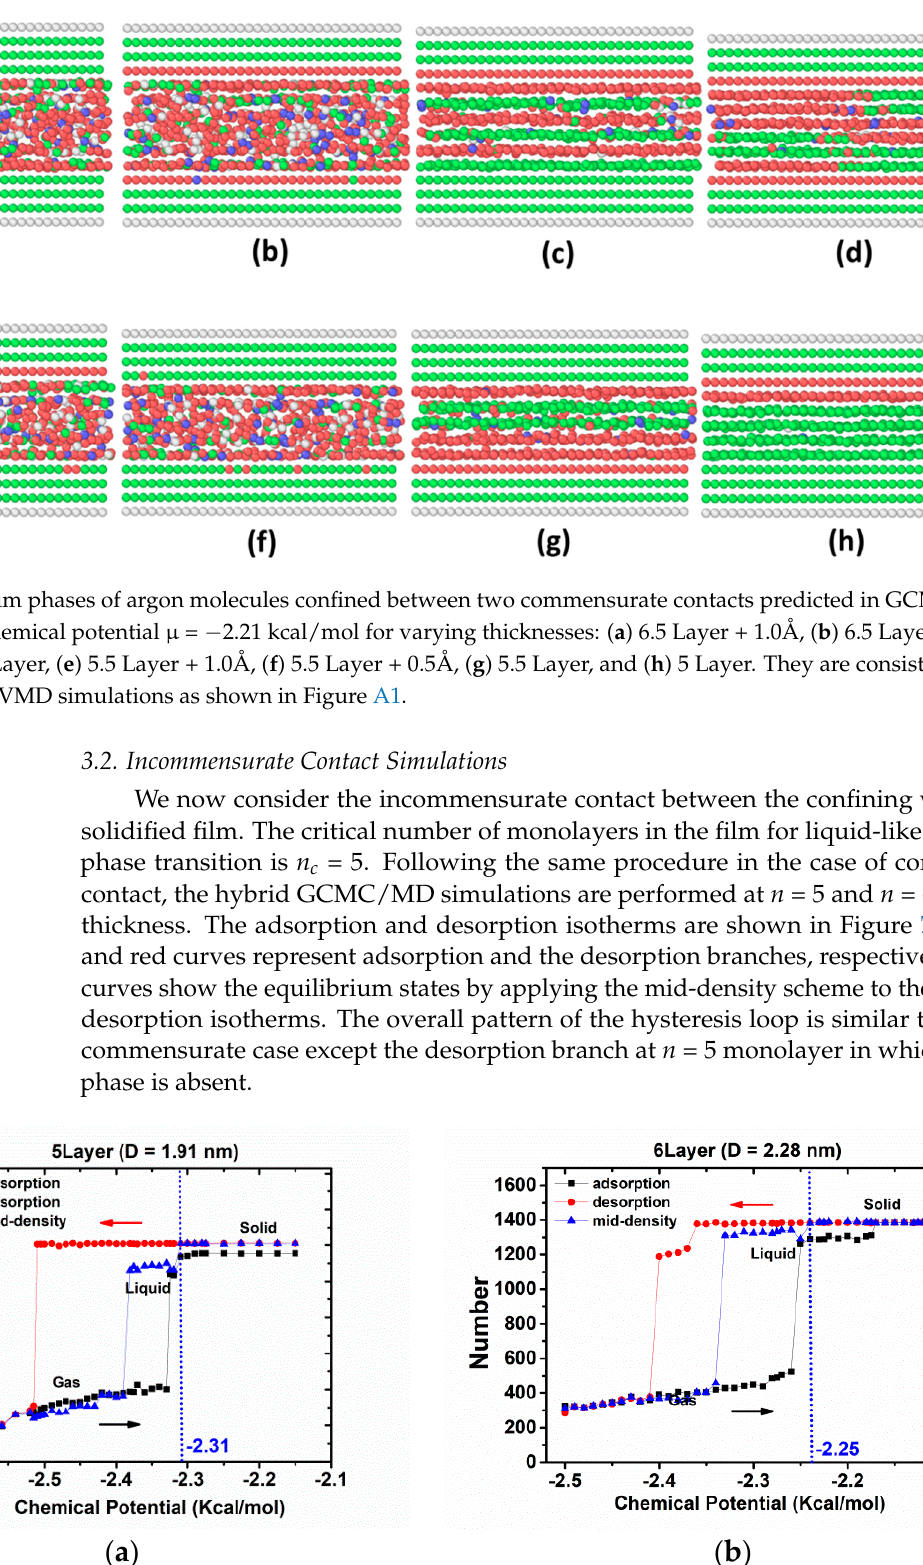
Figure 7. GCMC/MD simulations of adsorption (black) and desorption (red) isotherms for argon molecules confined be- tween two incommensurate contacts at 85 K at ( a ) n = 5 monolayer and ( b ) n = 6 monolayer thickness. The equilibrium states obtained by the mid-density scheme are shown in blue curves, on which the vertical dashed lines mark the phase boundary between liquid phase and solid phase.